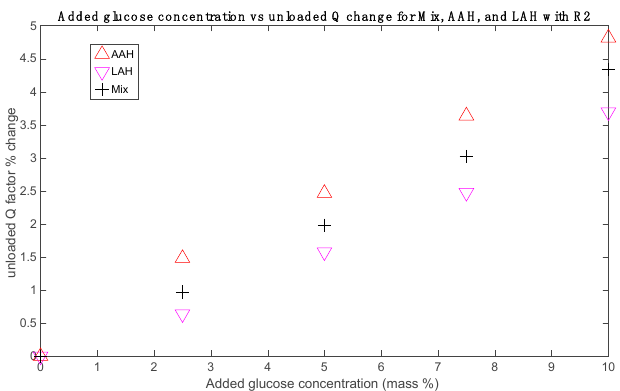
Figure 7. Results for Q u measurements for the Mix, AAH, and LAH sets with R2.